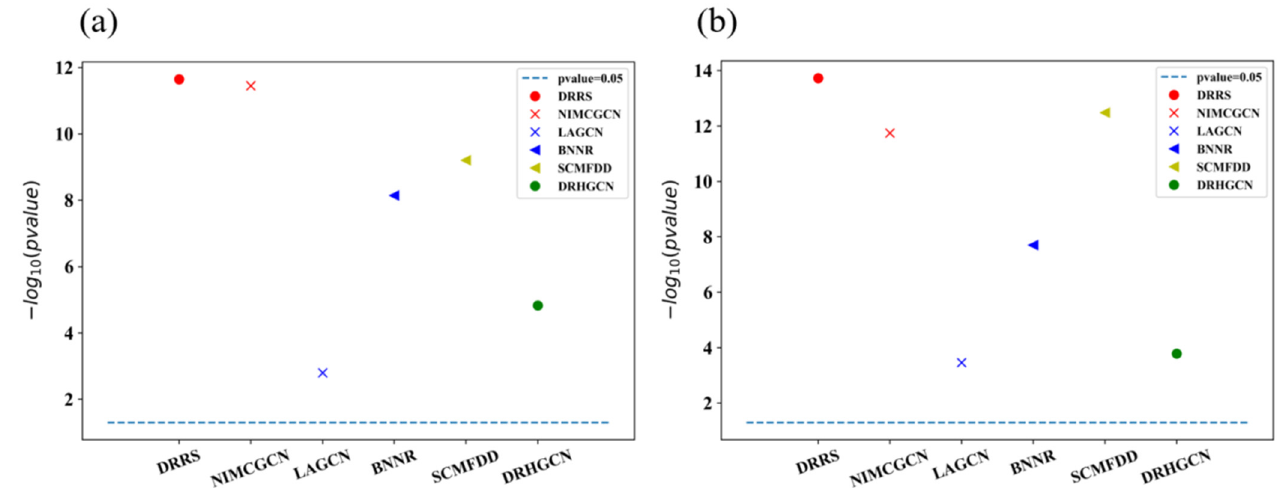
Figure 7. Statistically significant difference analysis of 10-fold cross-validation between EMPHCN and other methods on the T1 dataset. Since the p -value calculated by various models are quite unlike, we provide the result of − log ( p -value) instead of the p -value. ( a ) Significance analysis of AUC results. ( b ) Significance analysis of AUPR results.